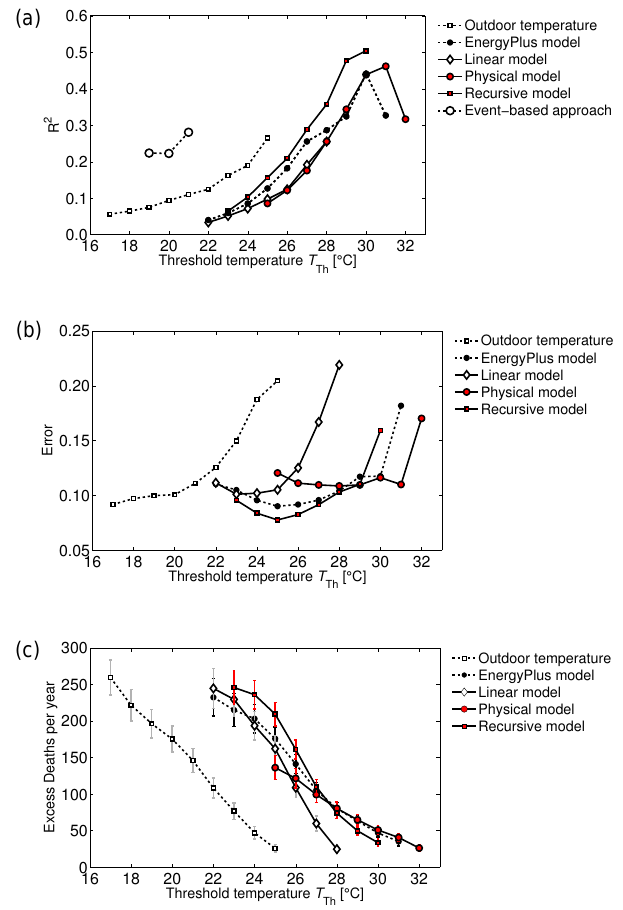
Figure 7. Coefficient of determination R 2 (top), relative standard deviation of the estimated vulnerability (middle), and calculated ex- cess deaths (bottom) for the time-series regression analysis in de- pendence of threshold temperature for outdoor hazard and indoor hazard calculated with EnergyPlus, linear, physical, and recursive building models. Results of the event-based regression analysis with a significance level of 0.1% are calculated according to Scherer et al.